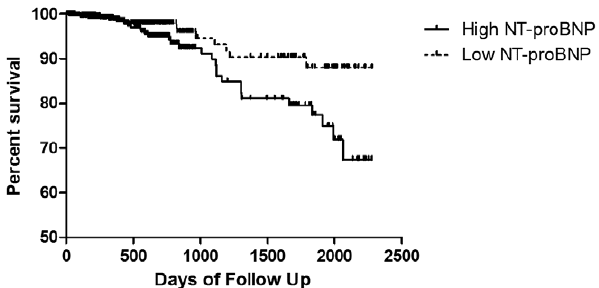
Figure 1. Univariate Survival Analysis. Kaplan-Meier survival curve of those with High ( $ 49 pg/mL) (solid line) versus Low ( , 49 pg/mL) (dashed line) NT-proBNP levels. Log-rank test=0.02. NT-proBNP=N- terminal pro-brain natriuretic